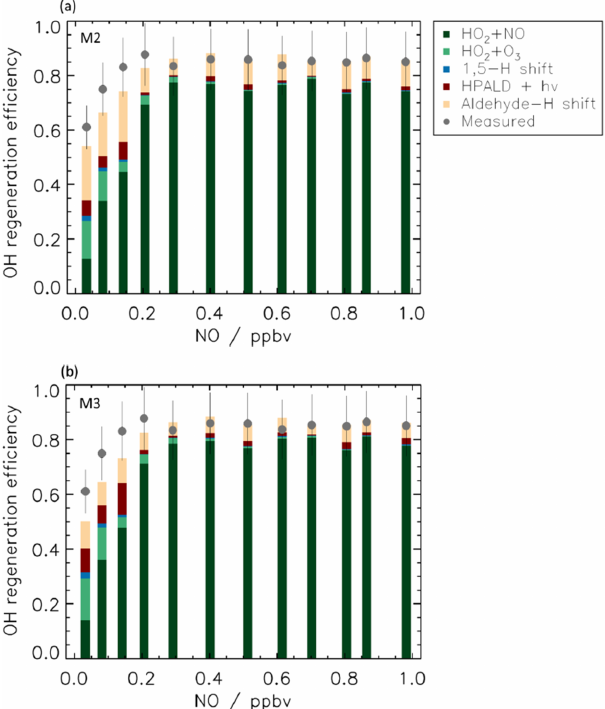
Figure 7. OH regeneration efficiency at different NO concentra- tions. The experimental OH regeneration efficiency (RE) is com- pared with the modelled one (M2, panel a ; M3, panel b ) for different NO values. The modelled OH RE is colour-coded by its main con- tributors (see Table S6 for more details). The RE is sustained at low levels of NO by the contribution from isomerization reactions, in particular by the aldehyde-H shift and its products. For [NO] higher than 0.3ppbv, most of the OH recycling originates from the reac- tion of HO 2 with NO, but, although to a small extent, isomerization reactions still contribute up to 2ppbv NO as the 1,6-H shift is still a competitive loss path for Z- δ -RO 2 radicals. The relatively large contribution to RE by the reaction between HO 2 radicals and O 3 at low NO is due to the large concentration of O 3 (90ppbv) needed in the simulation chamber to maintain low values of NO, and it is not representative of ambient conditions. Error bars (1 σ ) for the measured OH regeneration efficiency include the accuracy of the